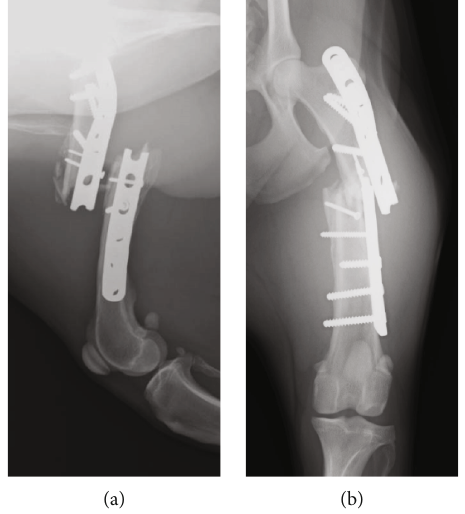
Figure 1: Preoperative radiographs. (a) Lateral view. b) Anterior-posterior